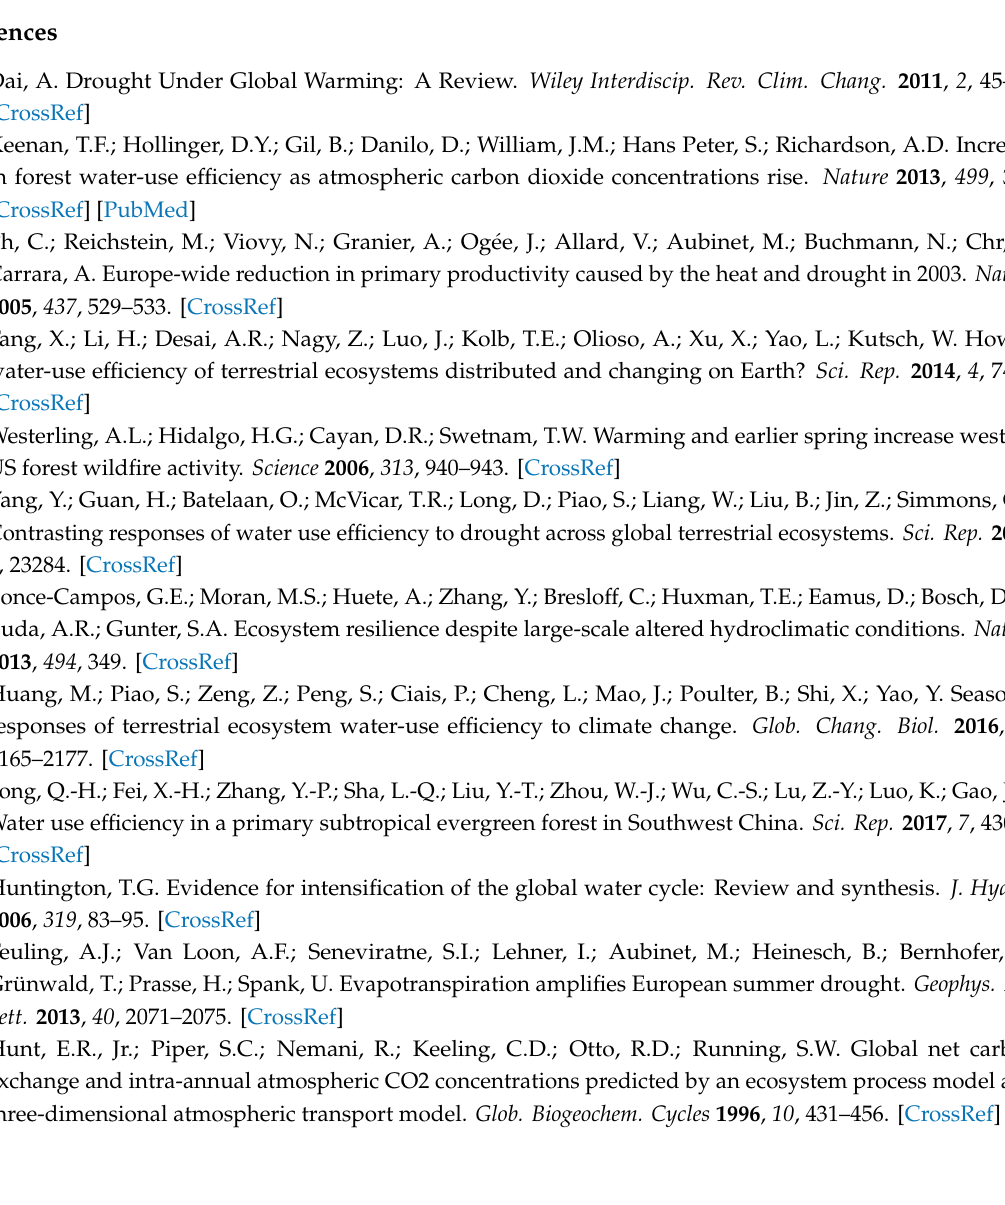
Figure S1: Average GPP and ET of Central Asia for the period